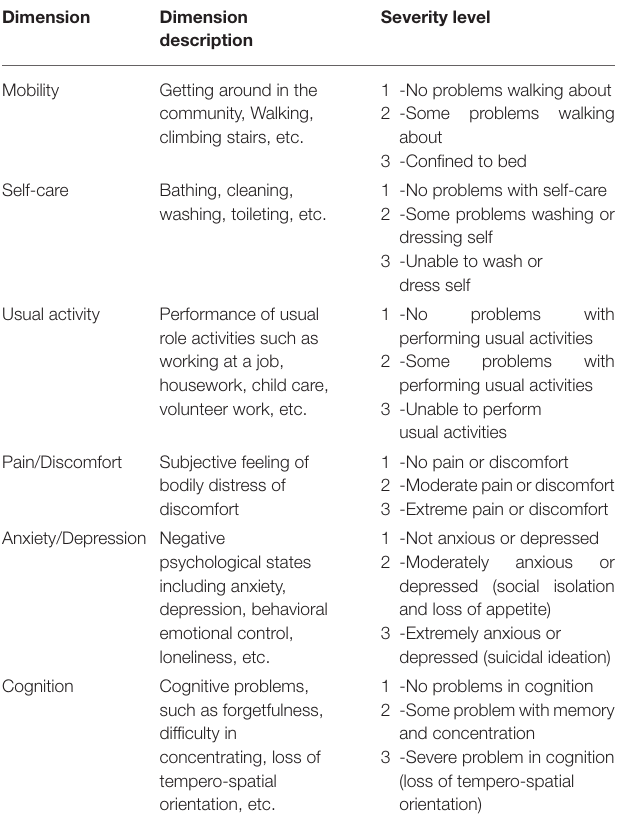
TABLE 1 | The 6D3L description system developed after field tests and medical consultations.